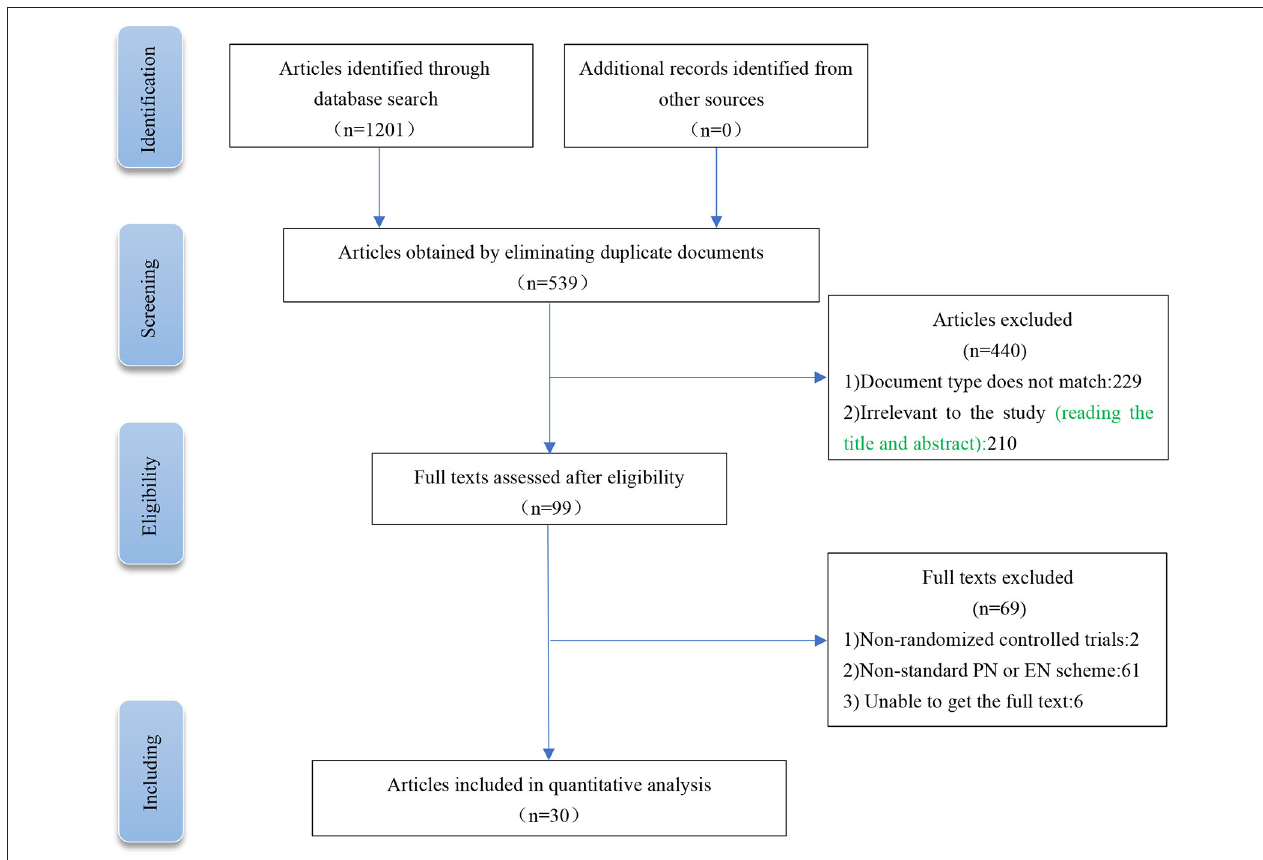
FIGURE 1 | Current meta-analysis article searching and screening strategies.